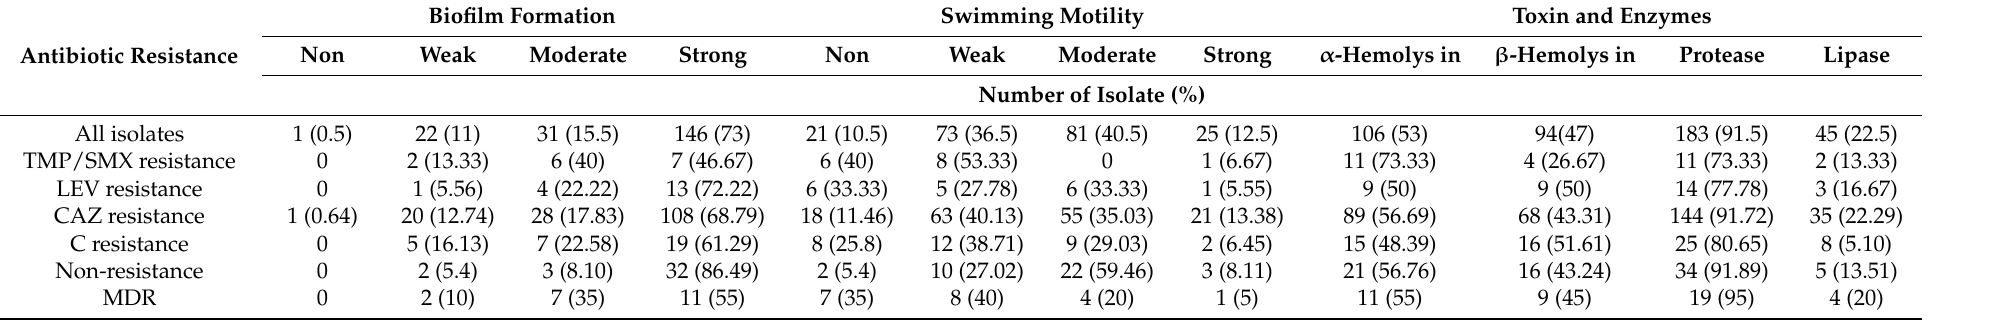
Table 4. Virulence phenotypes of S. maltophilia isolates stratified on the different resistance groups. Biofilm Formation Swimming Motility Toxin and Antibiotic Resistance